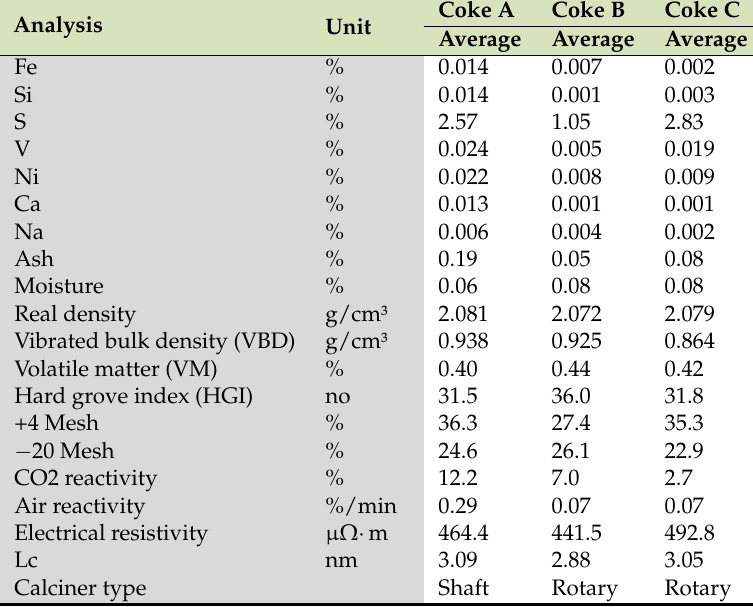
Table 2. Typical characteristics of calcined petroleum cokes (CPCs) used at the Emirates Aluminium (EMAL)